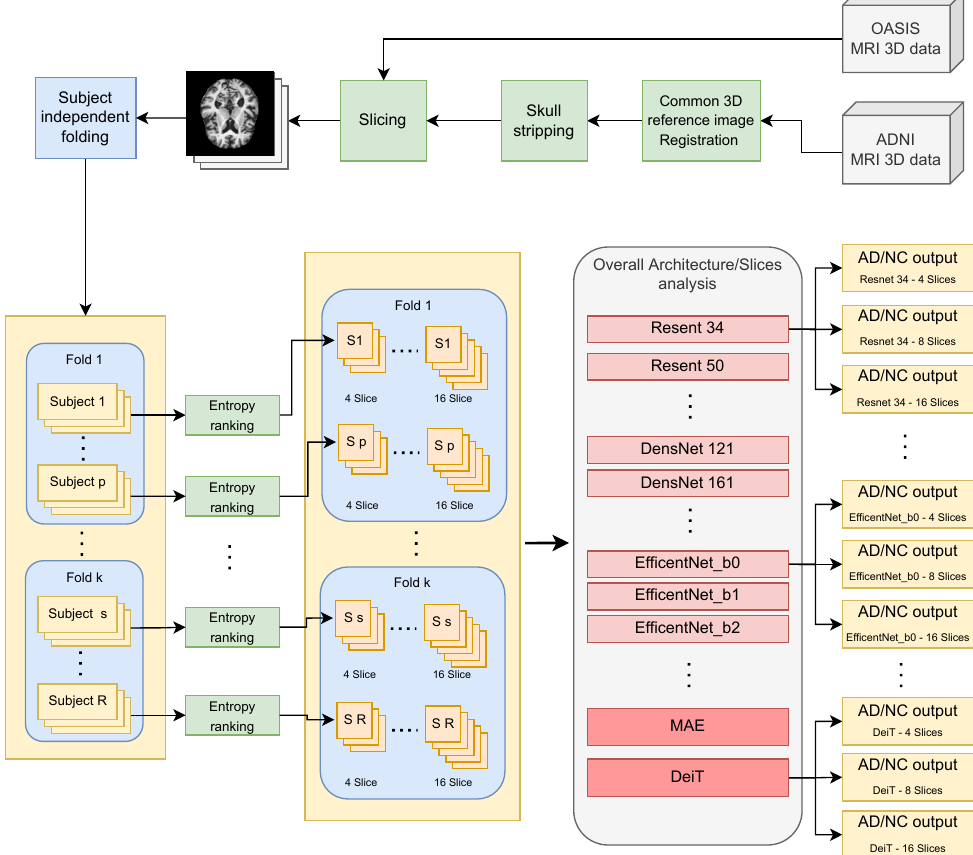
Figure 1. Research workflow: the input 3D data are preprocessed and divided into slices. Then, a k-folding is performed, taking care not to insert slices from the same subject into more than a single fold. The slices are ordered sequentially by their entropy value and prepared in groups of 4, 8, and 16 slices. Finally, the tests are performed in a k-fold manner through the different architectures working on different subsets defined by the number of slices retained per